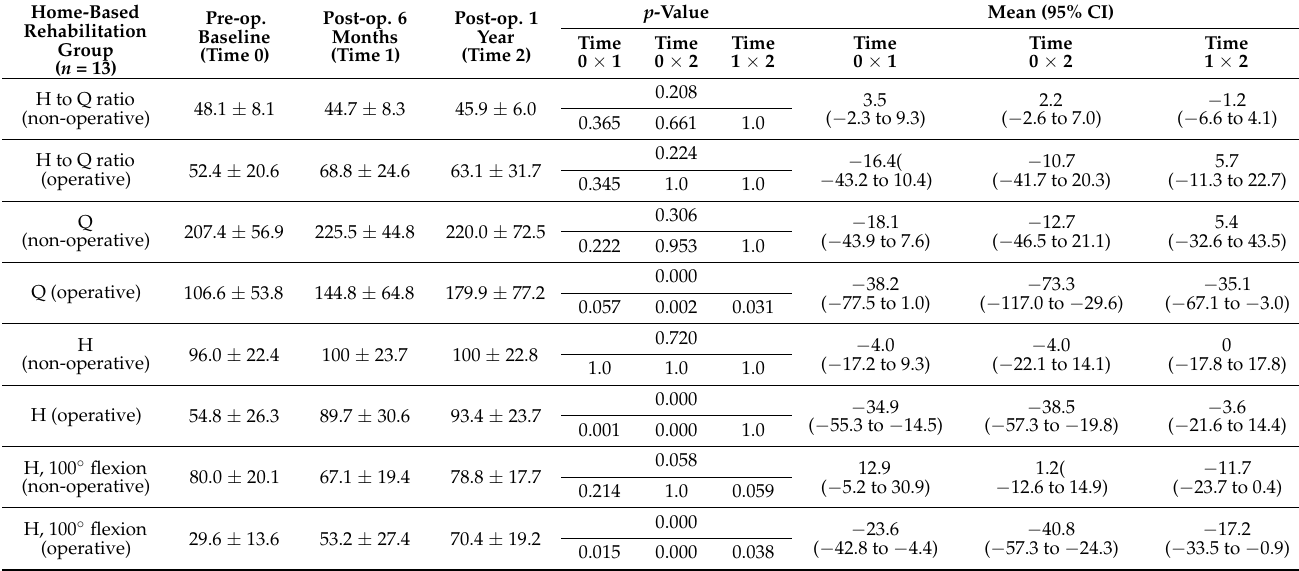
Table 3. Serial changes in muscle ratio and strength of quadriceps and hamstring of enrolled subjects in the home-based rehabilitation